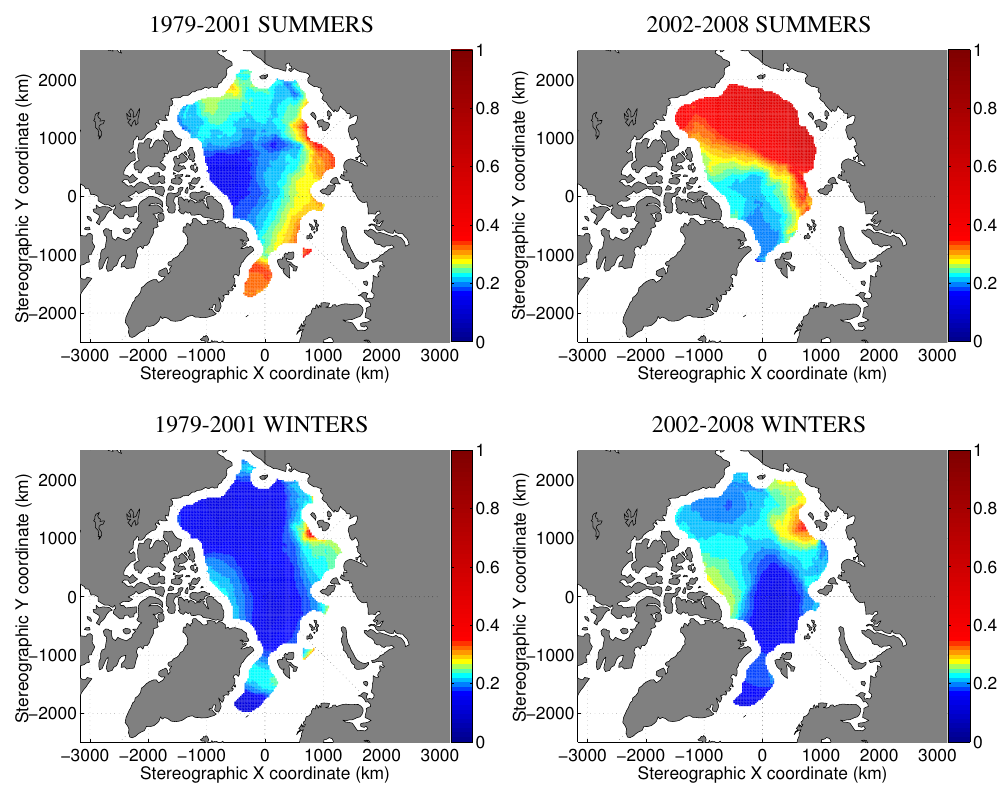
Fig. 12. Spatial repartition of M within the Arctic basin in summer and winter computed using the seasonal dataset of the period 1979–2001 and the seasonal dataset of the period 2002–2008. An average mean value of M , denoted M , is computed following Eq. (10) for each node of a 25 km resolution grid. The smoothing parameter L is equal to 400 km . In order to not represent regions with little data, an M value at a given grid point is plotted only if its associated weight is greater than a minimum value we arbitrarily set to 1000 . here, since they correspond to 1 − α values very close to 0 are sampled at buoy positions, as done in section 4.2,